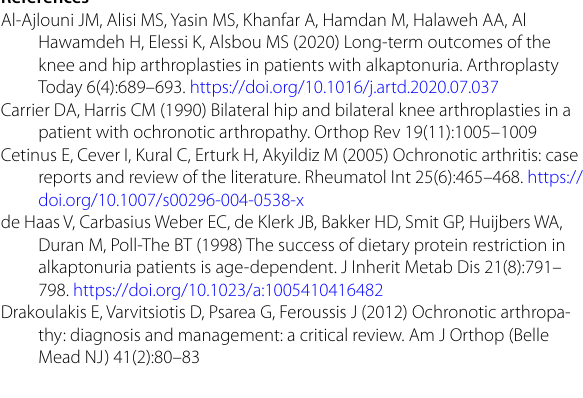
Fig. 5 Postoperative plain radiograph: A a cemented total hip replacement. B Total knee replacement